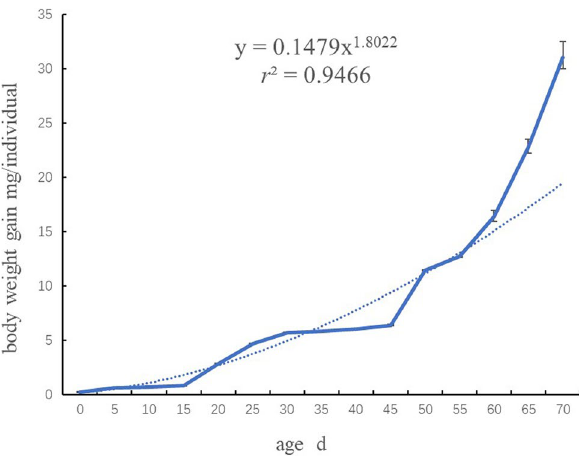
Figure 3. Growth curve (body weight gain over time) of juvenile Ligia exotica. n = 3 groups, each contain ten individuals from the same female. Dotted line is the trendline that generated in Microsoft Excel (https:// docs. micro soft. com/ zh- cn/ micro soft- 365/? view= o365- world wide). Microsoft 365 Apps for enterprise, Microsoft, USA. ± Bar means 95% confidence